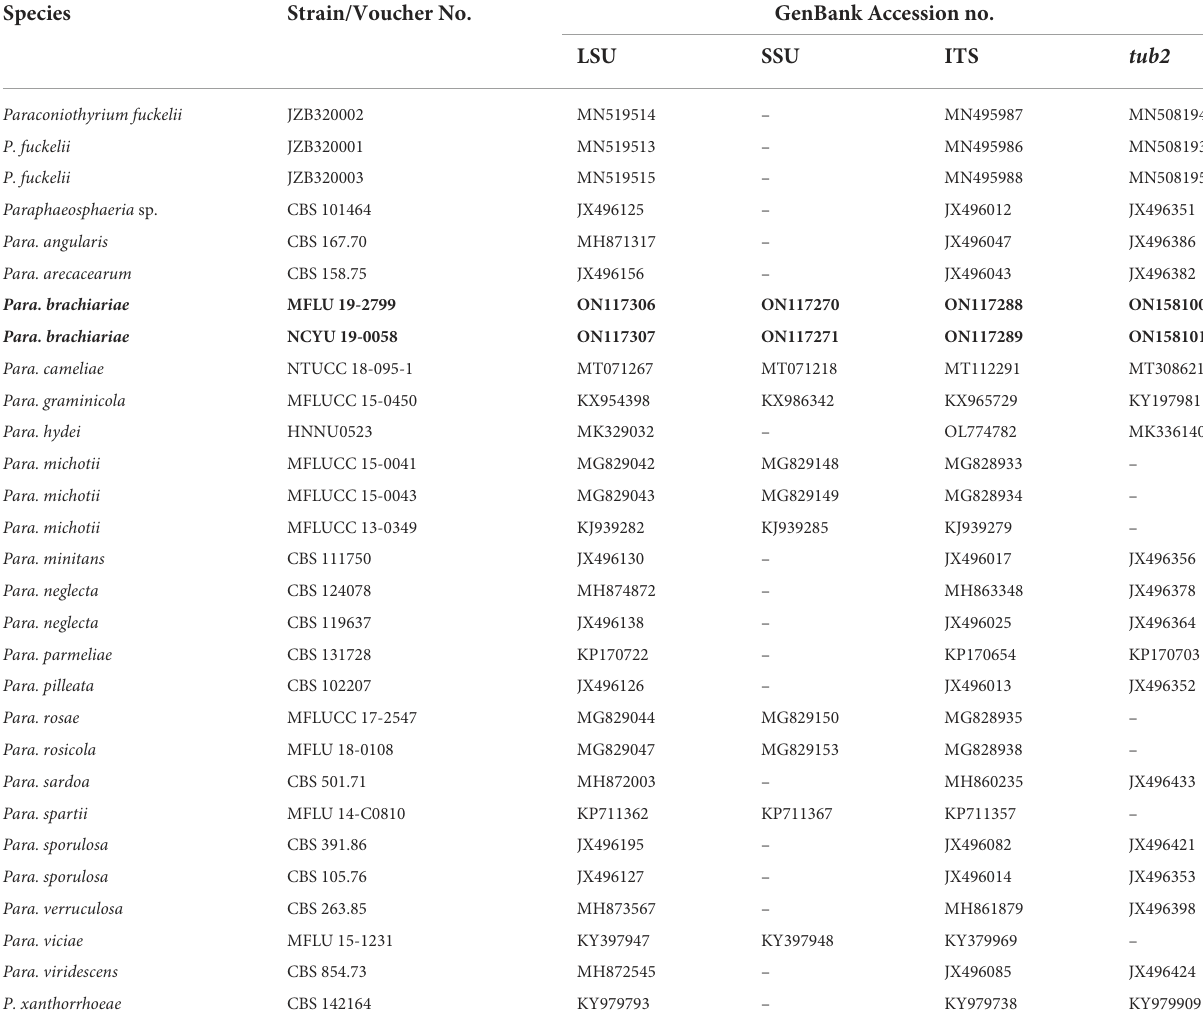
TABLE 3 GenBank and culture collection accession numbers of species included in this phylogenetic study ( Paraphaeosphaeria tree